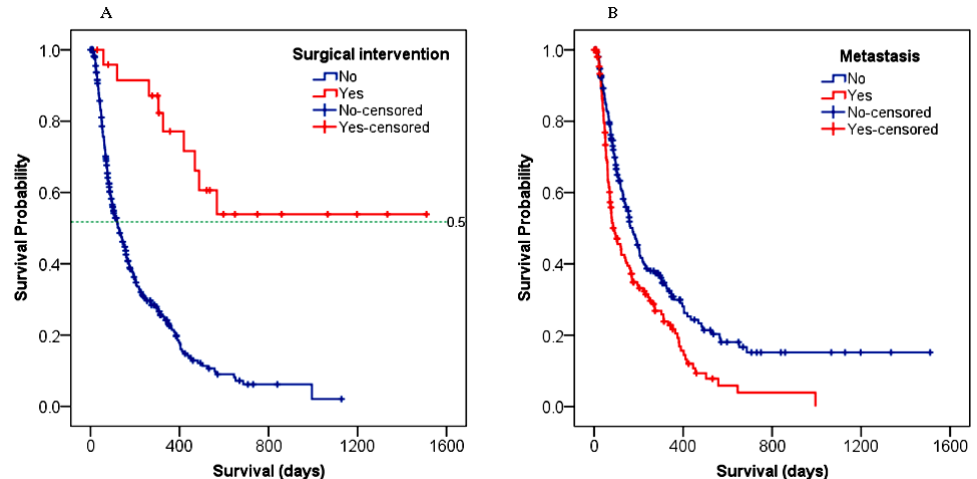
Figure 5. Survival differences among HCC patients: ( A ) with or without metastasis; ( B ) who received surgical intervention or not. “+” symbol represents censored patients who failed to follow-up or were alive at the end of the study.